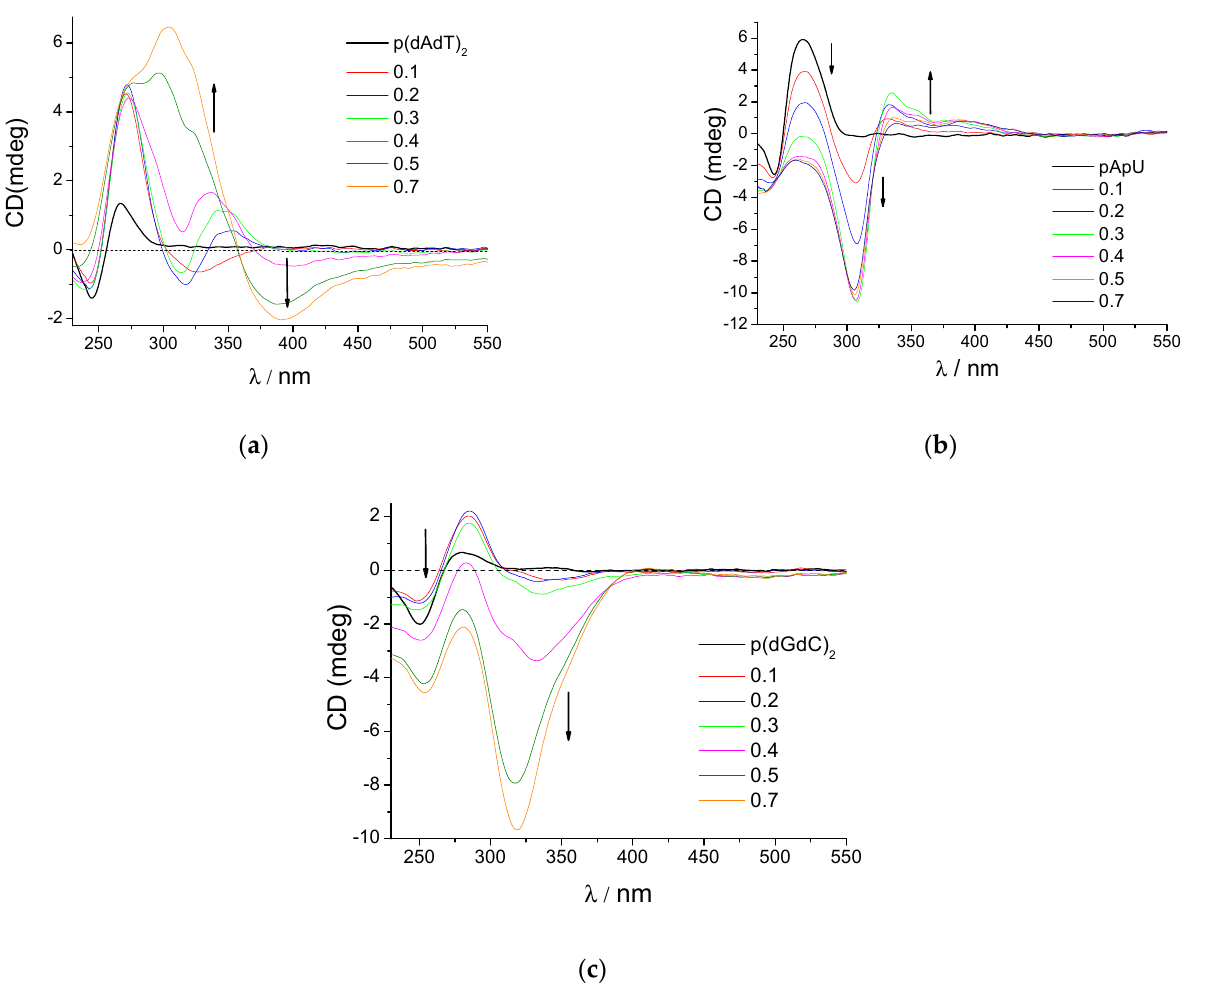
Figure 5. CD titration of ( a ) p(dAdT) 2 , ( b ) poly A–poly U, ( c ) p(dGdC) 2 ( c = 2 × 10 − 5 M) with 2M at molar ratios r = [compound]/[polynucleotide] (pH 7.0, sodium cacodylate buffer, I = 0.05 M). For AT-DNA, at a low ratio (r ≤ 0.1), weak negative ICD bands at λ = 300 − 350 nm were observed for 1M and 2M , indicative of intercalation between base pairs [56,57], which agrees well with the bathochromic and hypochromic changes in UV/vis titrations, high binding constants, and pronounced thermal denaturation stabilisation. The monomethylated 1M/ AT-DNA complex was characterised by an isoelliptic point at 297 nm (Figure 4a), supporting the formation of only one dominant type of complex. In contrast, further additions of 2M (r > 0.2) resulted in a strong negative ICD pattern, suggesting aggregation of pyrene molecules along ds-DNA [59]. The effect of 1M or 2M addition to AU-RNA was substantially different regarding the ICD band range at λ = 300 − 400 nm; at all ratios r, 1M caused a systematic increase of the positive ICD band with isoelliptic point at 300 nm (Figure 4b), which is characteristic of RNA major groove binding of a single molecule [59], while the addition of 2M resulted in very strong bisignate ICD bands with coupled negative-positive ICD bands in 280–400 nm range (Figure 5b) ascribed to the formation of pyrene-dimers or higher aggregates within the RNA major groove [59]. At an excess of GC-DNA over 2M (Figure 5c, ratio r < 0.2), a weak negative ICD band at 310-340 nm appeared, typical of intercalative binding [58,59]. However, only 2M induced an exceptionally strong negative ICD band at an excess of 2M over GC-DNA